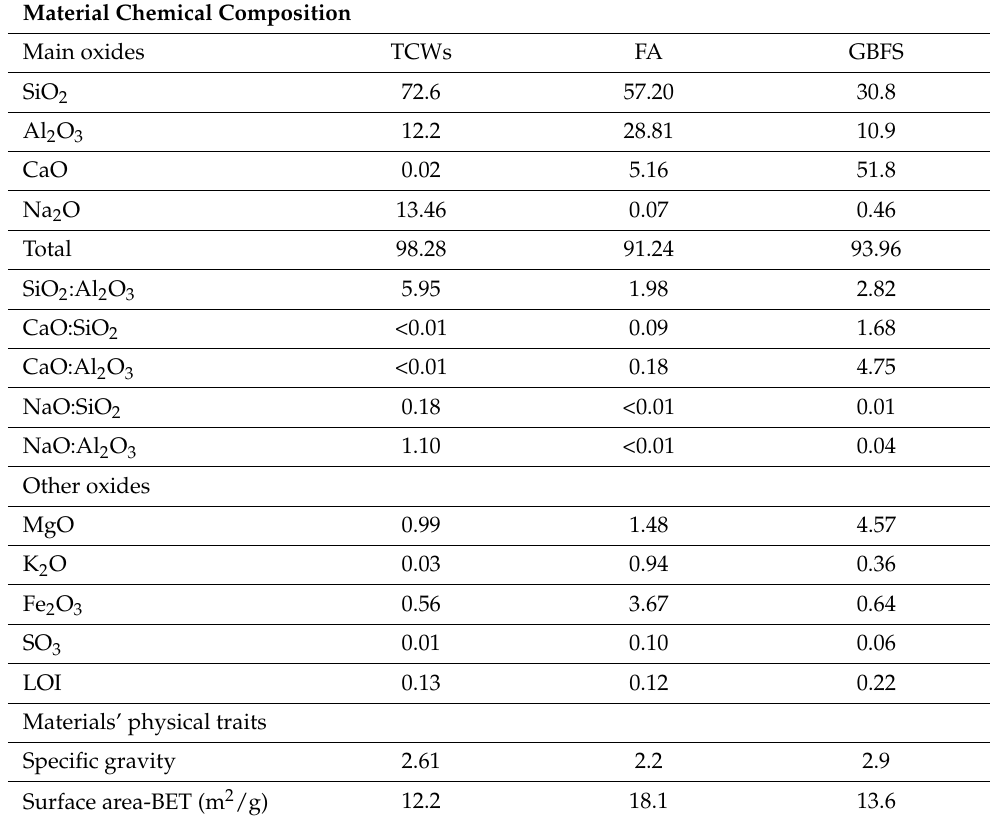
Table 1. Chemical and physical attributes of raw materials based on XRF